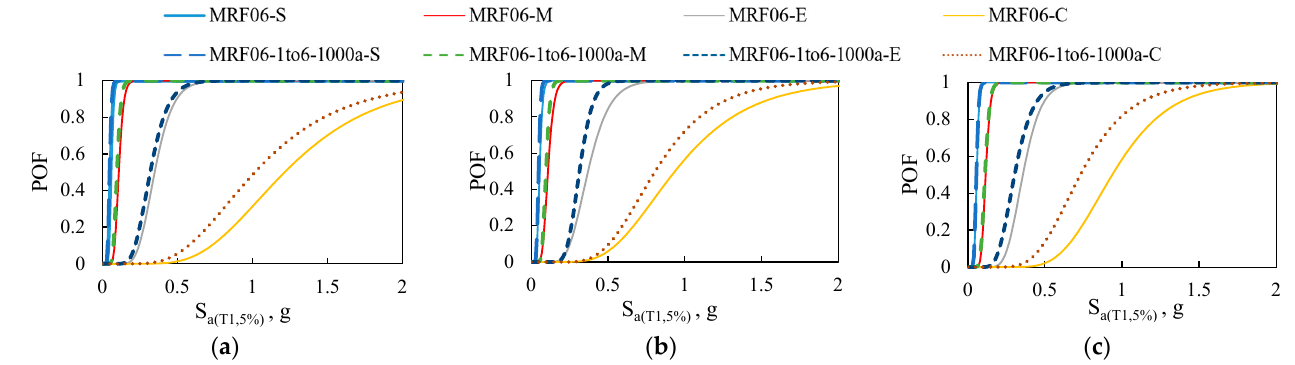
Figure 10. Fragility curves of 6-story structure subjected to ( a ) FF, ( b ) NF-No Pulse, and ( c ) NF-Pulse records, respectively.